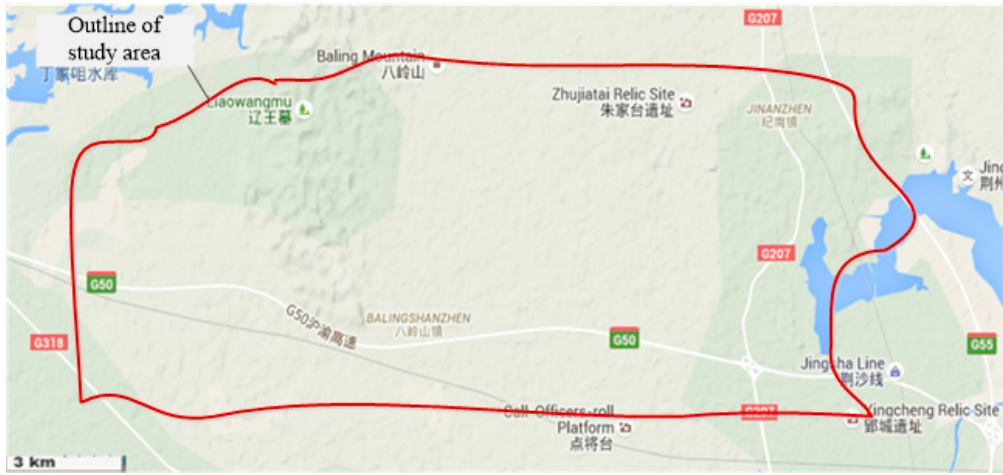
Figure 1. Study Area: Balingshan Chu Tomb Group.